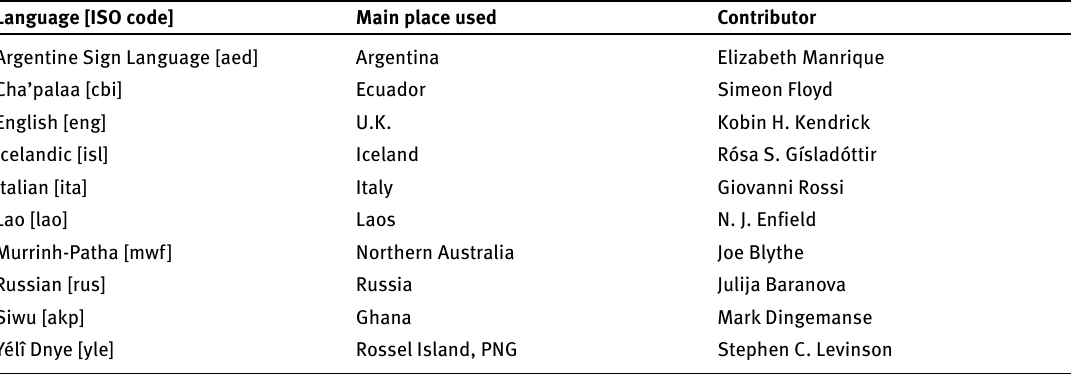
Table 1: Languages and contributors in this special issue